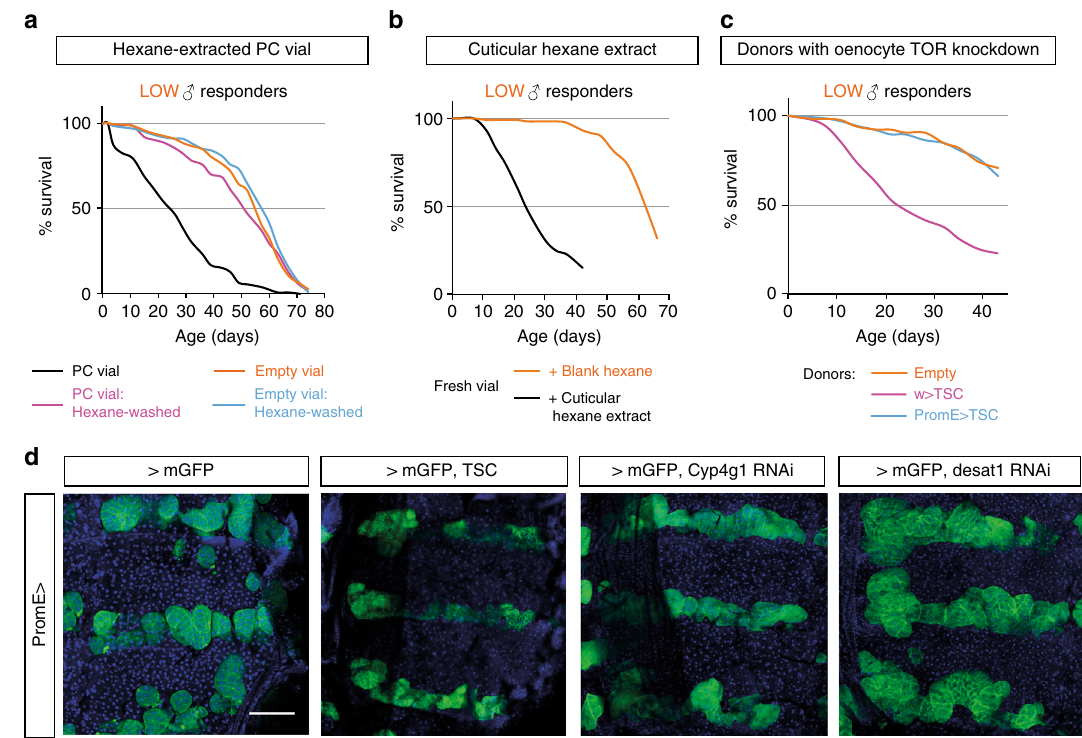
Fig. 5 Autotoxins are oenocyte-derived cuticular lipids. a , b Survival curves for LOW responder males showing that hexane extracts the autotoxin activity from preconditioned (PC) vials a or from adult cuticle b . c Autotoxin activity is not detectable in vials preconditioned with STD male donors overexpressing TSC1 + 2 in oenocytes ( PromE TS > TSC ), unlike control ( w > TSC ) or non-preconditioned vials (empty). d Dorsal oenocytes from 1 week STD males of a control genotype ( PromE TS > mGFP ), TSC1 + 2 overexpression ( PromE TS > ; mGFP, TSC ), Cyp4g1 RNAi ( PromE TS > mGFP, Cyp4g1 RNAi ) or Desat1 RNAi ( PromE TS > mGFP, Desat1 RNAi ). Oenocytes and nuclei are marked with mCD8::GFP (green) and DAPI (blue), respectively. Scale bar = 100 μ m. In this and subsequent fi gures, PromE TS driven expression was restricted to adulthood (Methods